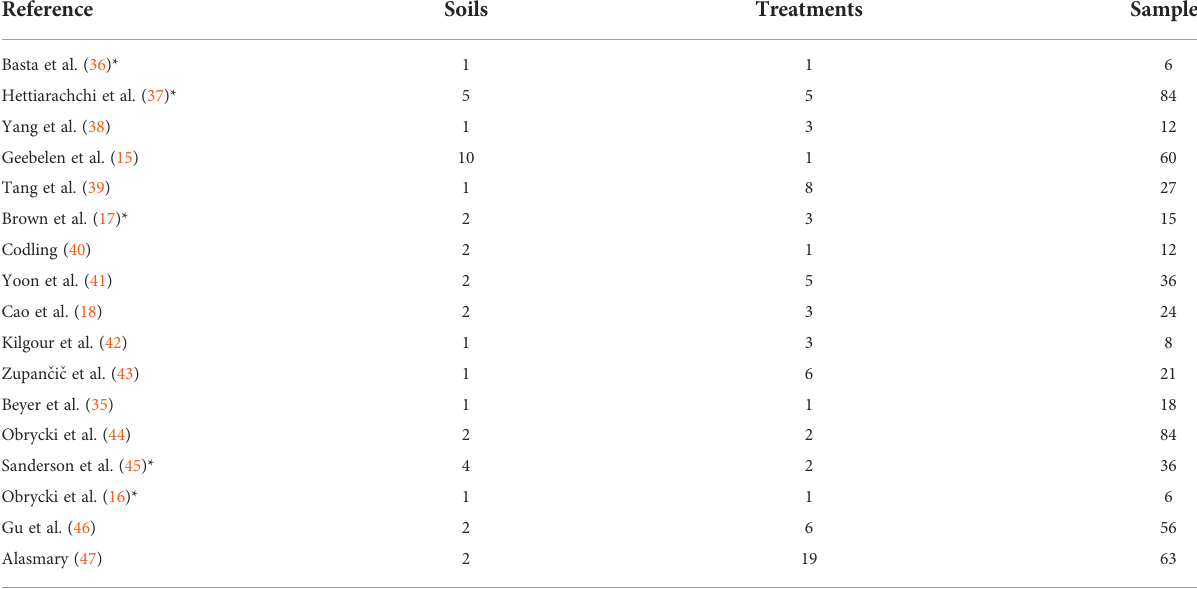
TABLE 1 Studies included in the primary group with the number of soils, non-control treatments and total number of samples in each study.